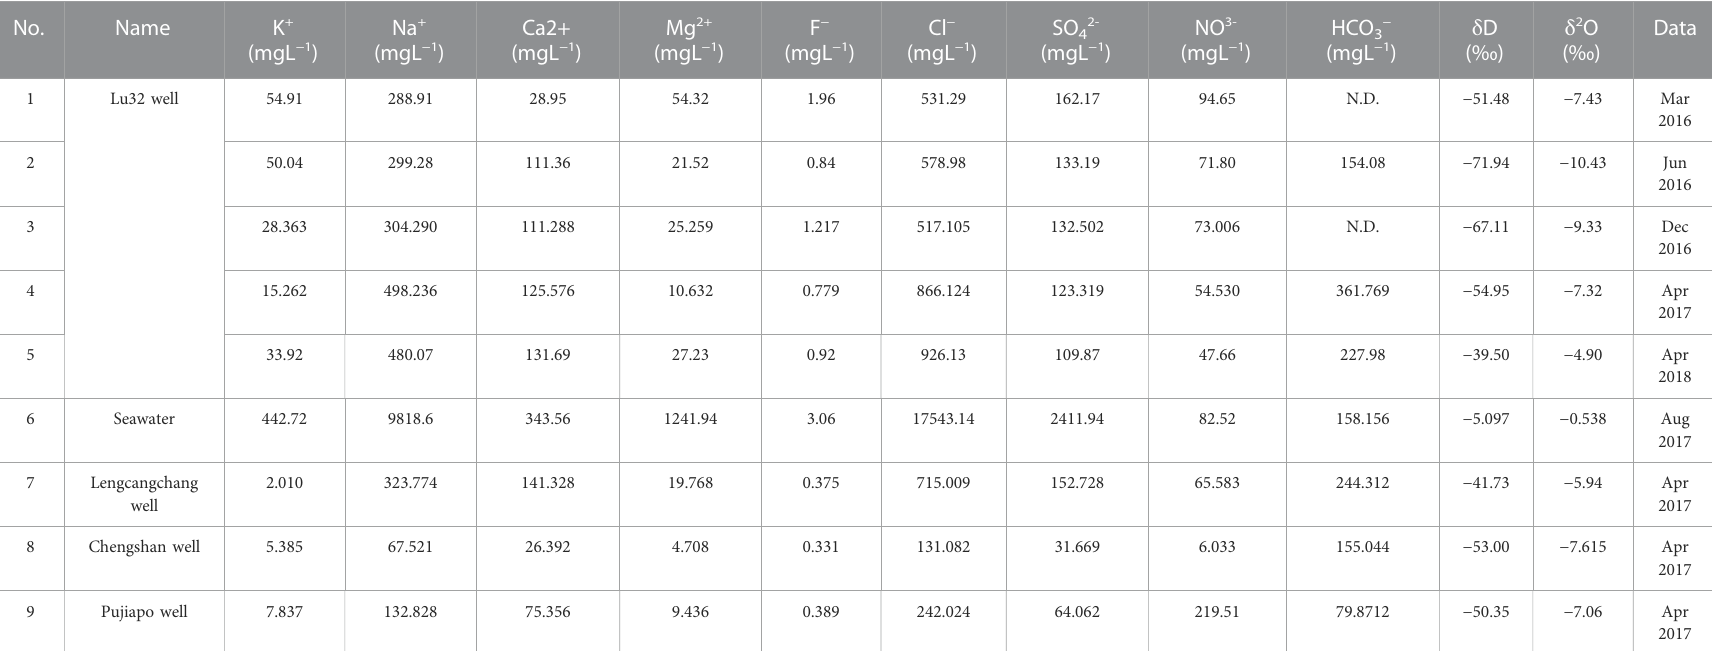
TABLE 1 Hydrochemical characteristics of the No. Lu 32 well and seawater in the Jiaodong Peninsula.